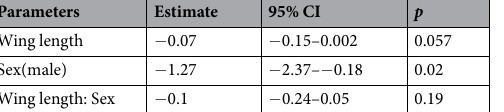
Table 1. The summary of a general linear model regarding the effect of wing length and sex on total iris flecking in 76 common